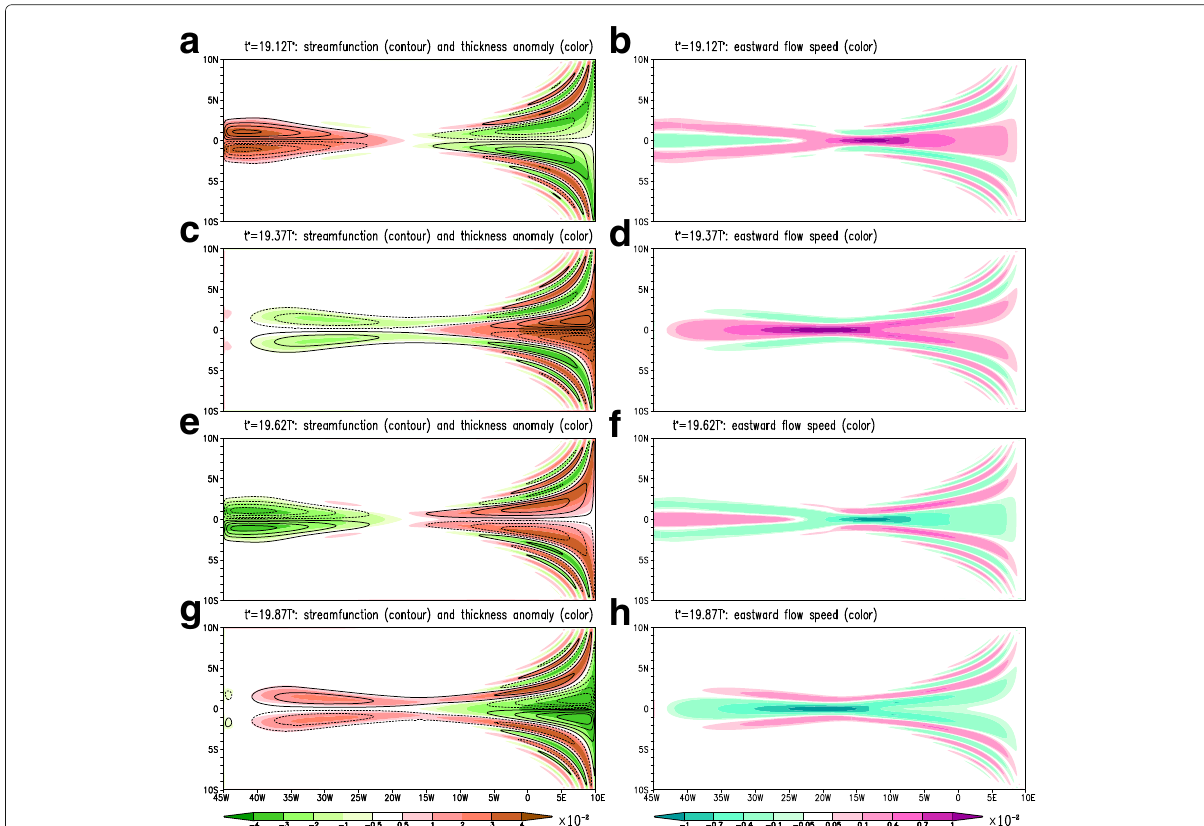
Fig. 4 Leftpanels are the snapshots of the EPV-based streamfunction ϕ app ∗ ( solid and dottedline contours for positive and negative values, respectively, with an interval of 60 m 2 / s) and thickness anomaly ( colorshading , normalized). Rightpanels are the snapshots of the zonal component of velocity u ∗ ( colorshading , m / s). These snapshots have been adapted from the 20th cycle of the model experiment, wherein the period of the oscillatory forcing is T ∗ = 4.5 years; the reference layer thickness is H ∗ = 100 m, and the equatorial deformation radius is